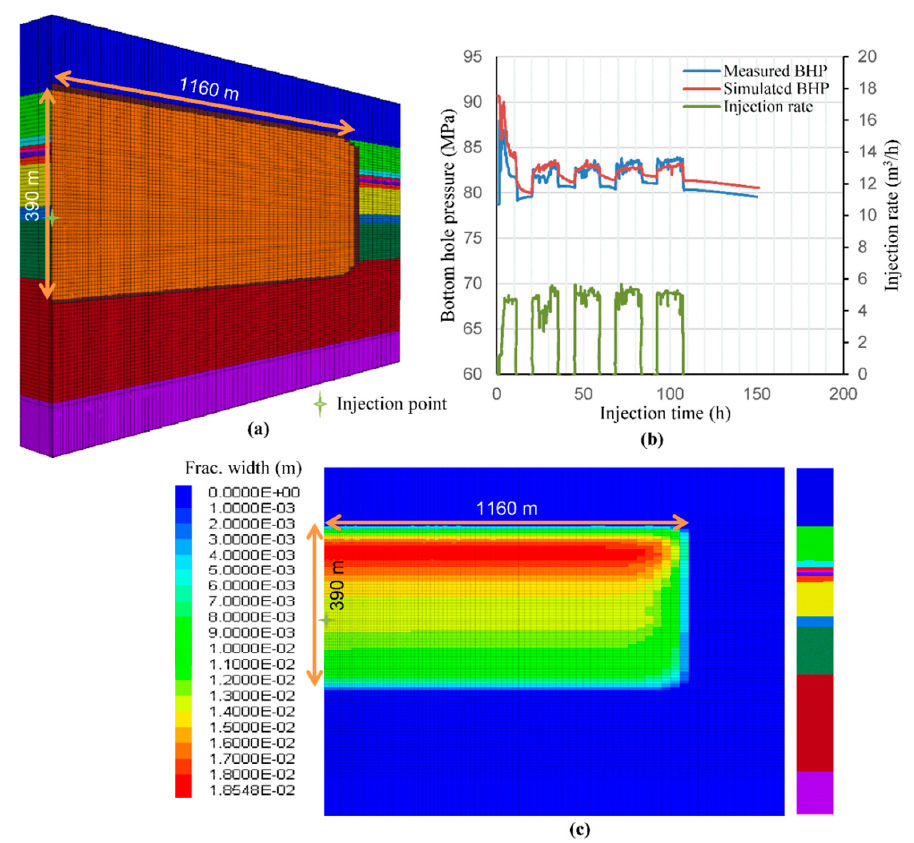
Figure 14. Results of fracturing operation showing (a) 3D ¼ geometrical model with created fracture, (b) comparison of simulated bottom hole pressure (BHP) with measured BHP for model verification, and (c) fracture geometry at the end of injection.